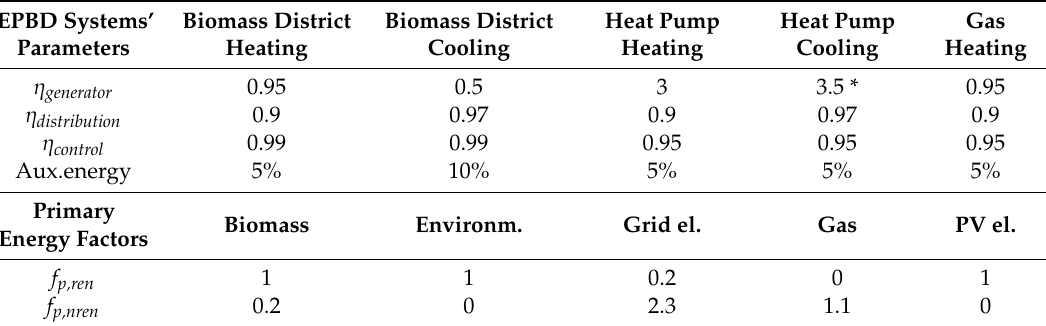
Table 2. Parameters considered in the analysis.